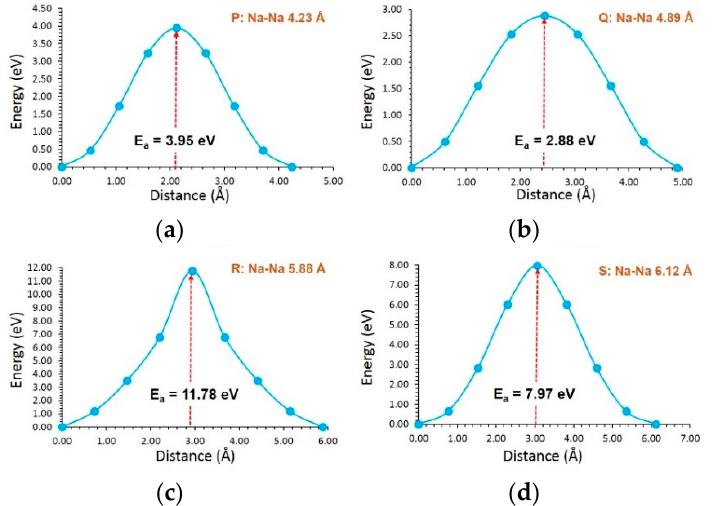
Figure 5. Energy profile diagrams for the local Na-ion hopping of ( a ) P, ( b ) Q, ( c ) R and ( d ) S in NaVSi 2 O 6 .